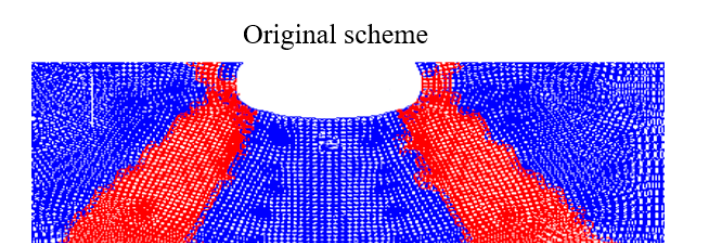
Figure 19. Optimized pile length.